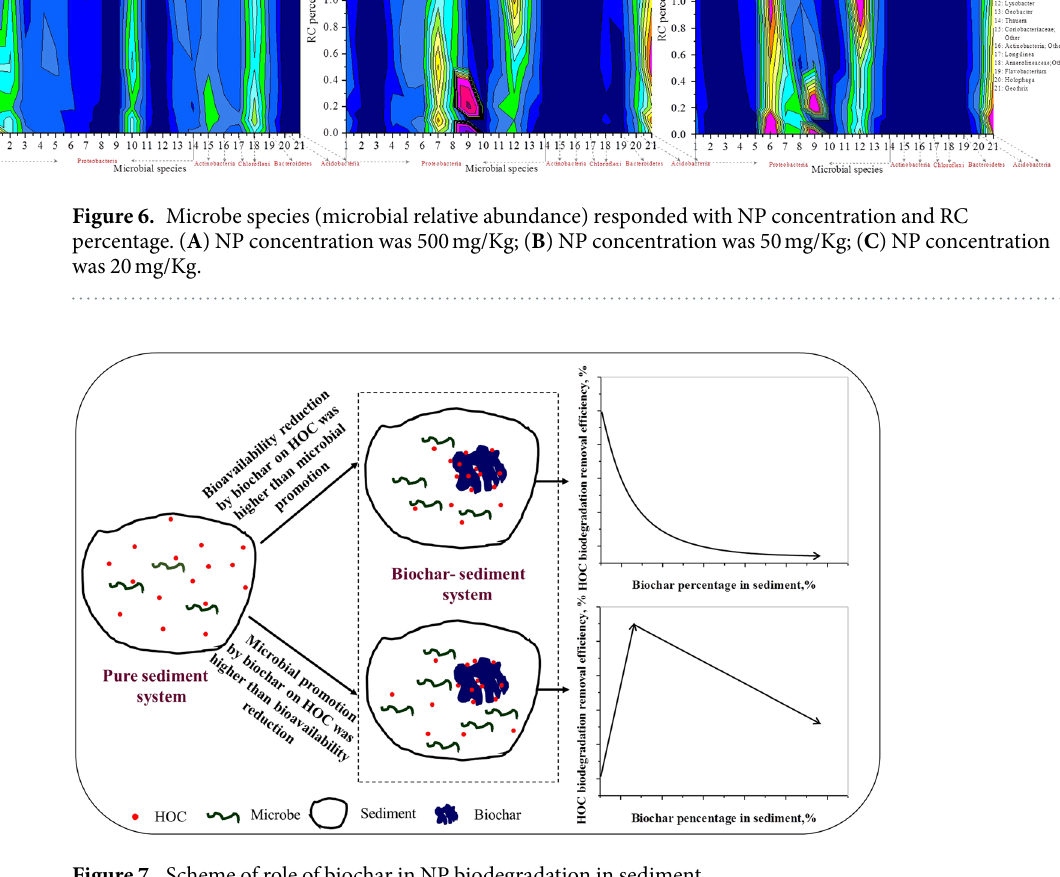
Figure 7. Scheme of role of biochar in NP biodegradation in